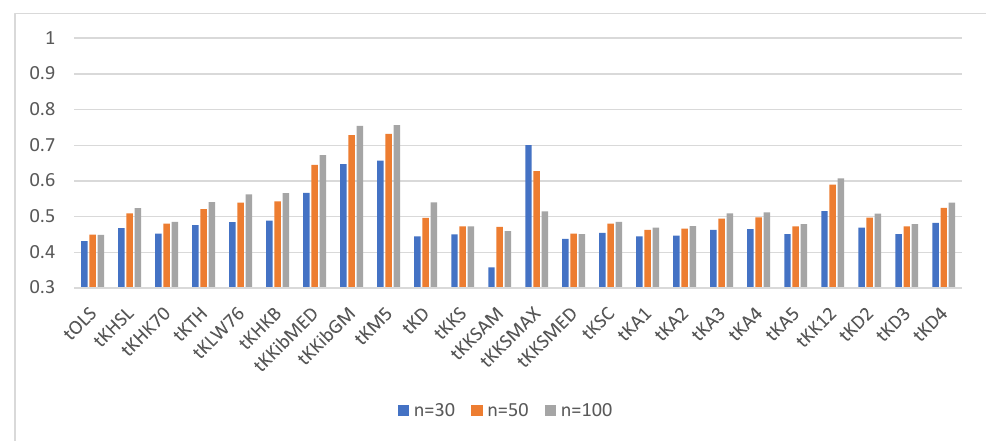
Figure 3. Power of the test for correlation coefficient 0.80 and q = 10.